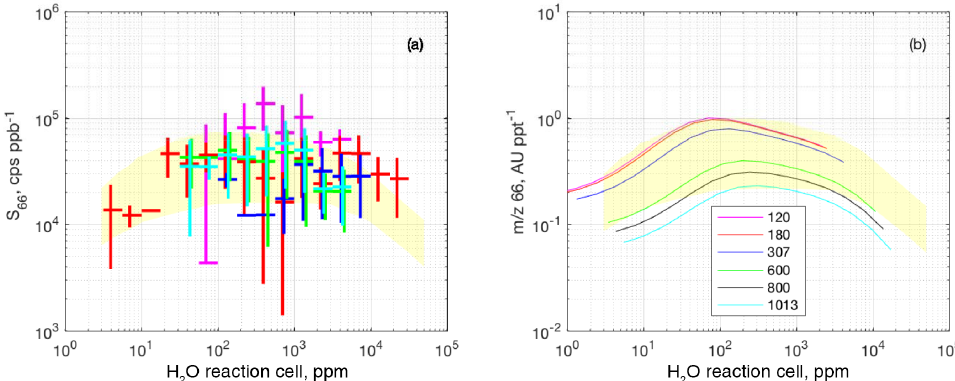
· ( H Figure 5. (a) Experimental sensitivity (counts per second per ppb, cpsppb − 1 ) trend in O − 2 O 2 ) as a function of reaction cell water 2 = 0.0005 (cyan) and 0.001 (green)slpm]. All vapor mixing ratio ( χ H , ppm), from DC3 (red), FRAPPE (blue), and the laboratory [ F CH 2 O 3 I calibrations were binned by χ H and bin widths are shown by the horizontal lines. Vertical bars indicate one standard deviation of a bin 2 O and include sample pressure variation effects, water variation within a bin, precision of the standard addition calibration gas concentration, instrument precision and ambient mixing ratio variation across the standard addition period. There were fewer than four observations per bin in FRAPPE for water vapor mixing rations less than 10 3 ppm. Magenta crosses in panel (a) correspond to DC3 post mission calibrations without the addition of CH 3 I and after there had been multiple refills of the reagent CO 2 in air bottle. (b) Normalized simulated sensitivity as a function of χ H for six different sample pressures as shown in the legend. The yellow shading maps the trends in experimental 2 O sensitivity (a) to the calculated trends in sensitivity (b) using the same normalization process.